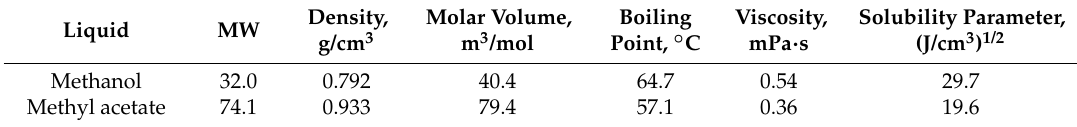
Table 3. Physical properties of liquids under the study